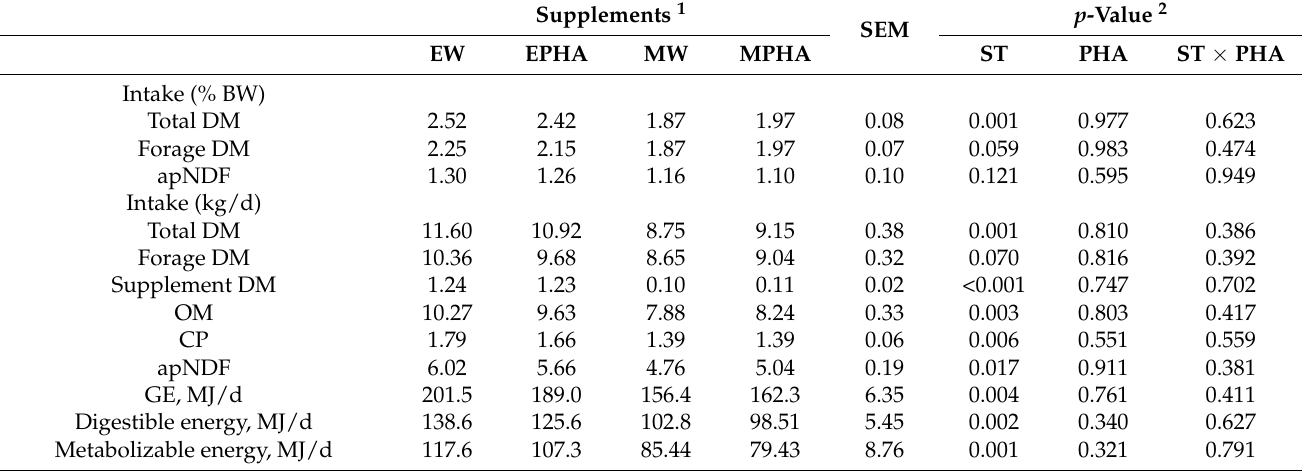
Table 2. Effect of phytogenic compounds in mineral or energy supplementation on intake and apparent total digestibility of Nellore cattle grazing Urochloa brizantha cv. Marandu during the rainy